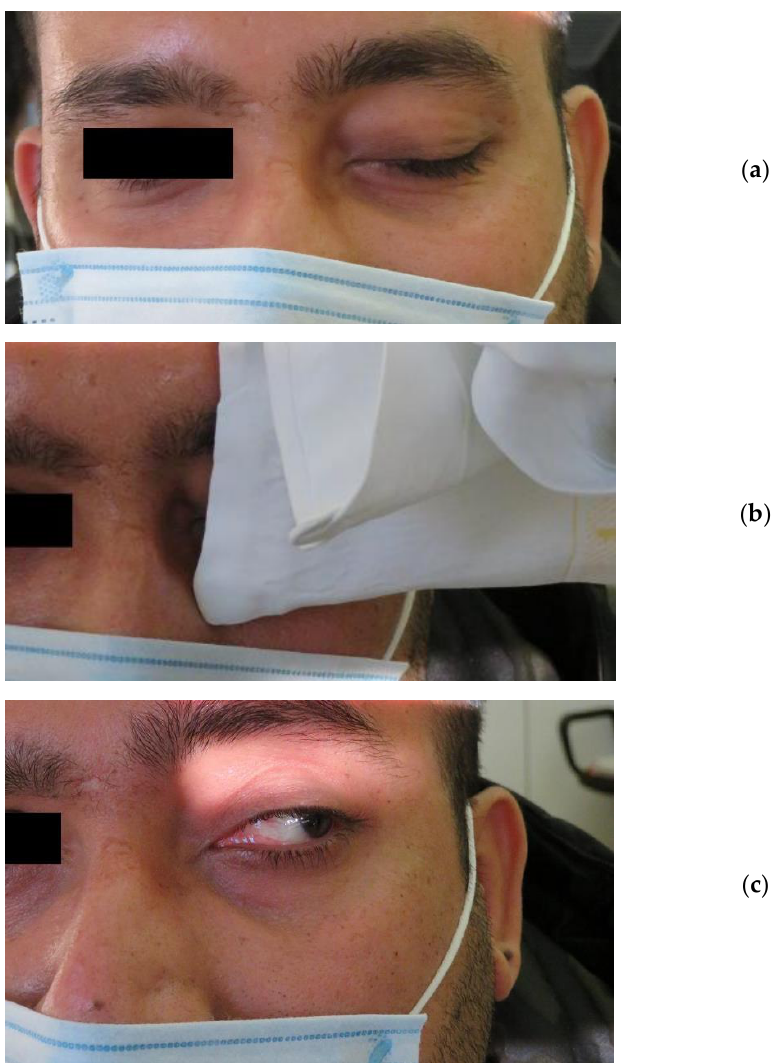
Figure 1. Ice pack application in a patient with neurogenic ptosis. ( a ): Unilateral left-sided ptosis. ( b ): Ice pack over the left drooping eyelid. ( c ): Improvement of the ptosis.